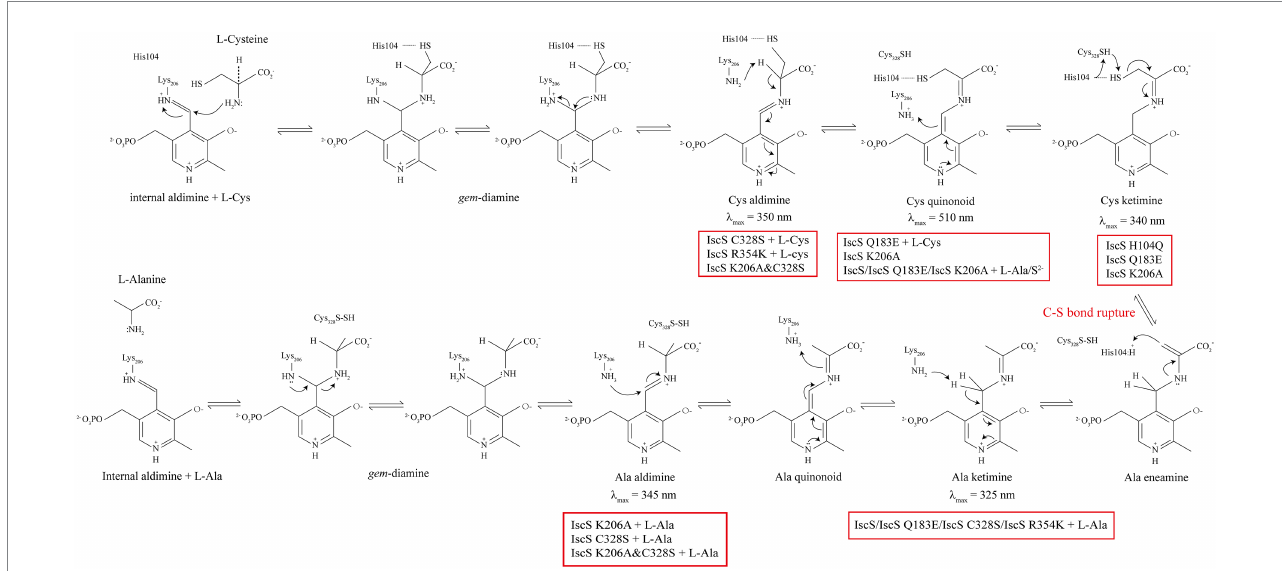
FIGURE 9 Proposed intermediates of Escherichia coli IscS formed in the reaction coordinate. The red box indicates the IscS variants or the reaction that can generate the corresponding intermediate